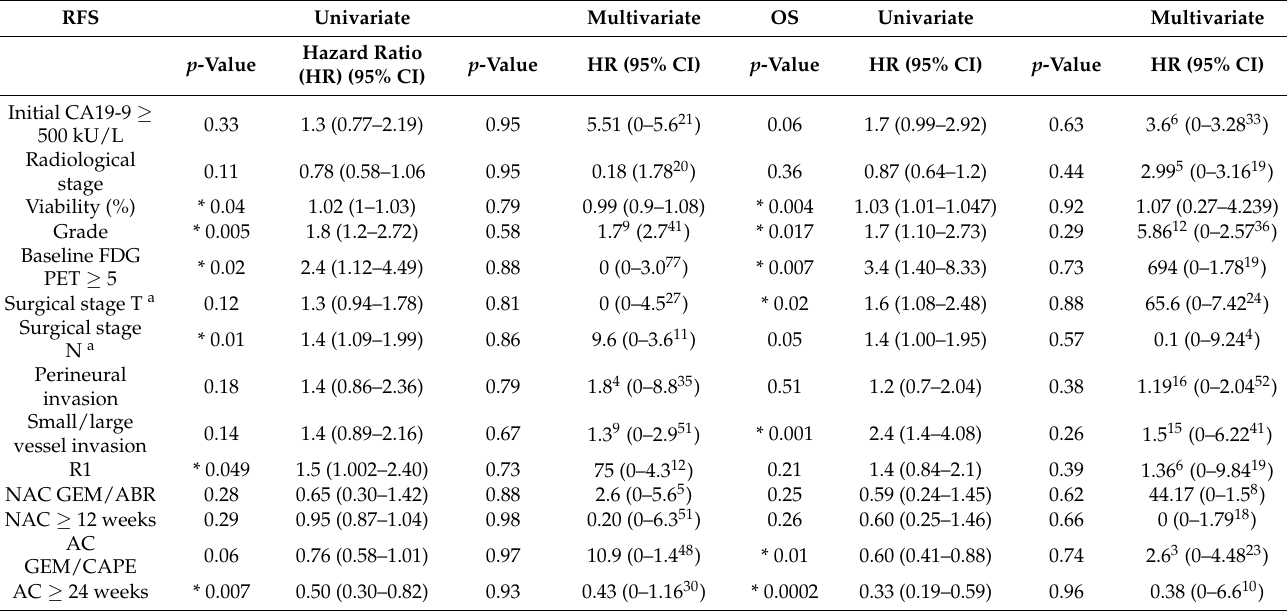
Table 2. Univariate and multivariate prognostic markers for recurrence-free and overall